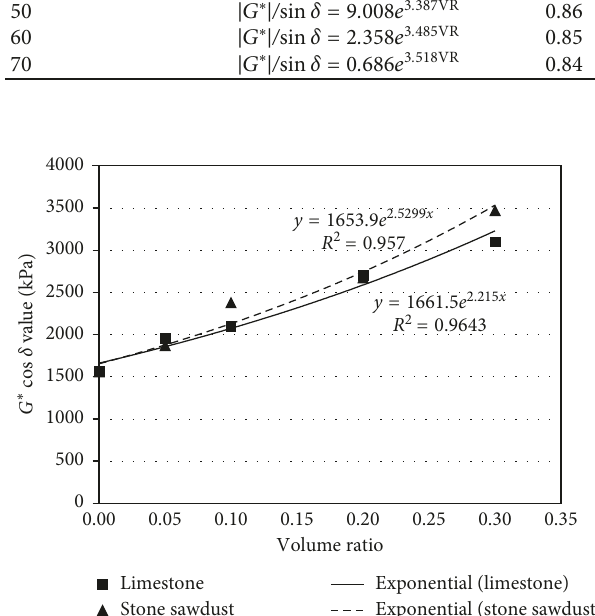
Figure 8: Elastic behavior of asphalt mastics at 10 ° C and 1.78Hz versus VR.